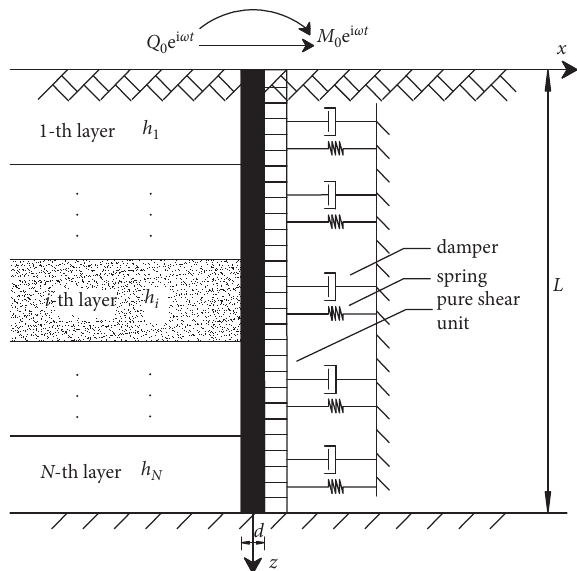
Figure 1: Double shear model of pile-soil